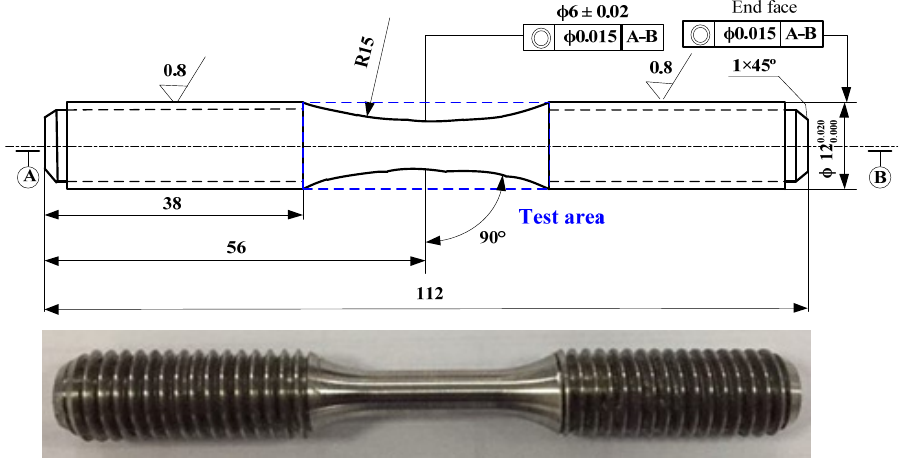
Figure 5. Geometric characteristics of the fatigue specimen.